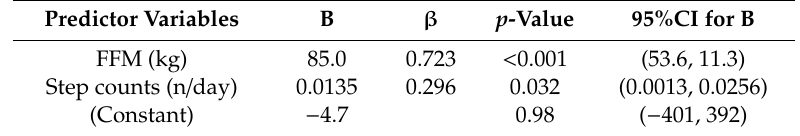
Table 4. Multiple linear regression analysis for predicting TDEE (kcal / day) in 4–6-year-old children. Predictor